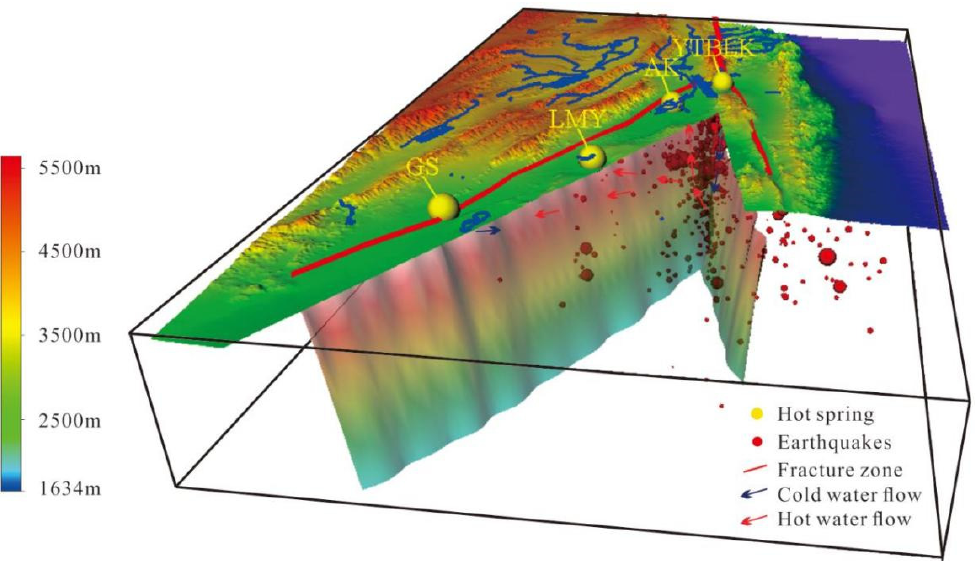
Figure 9. Conceptual model of the hot spring circulation in the study area.